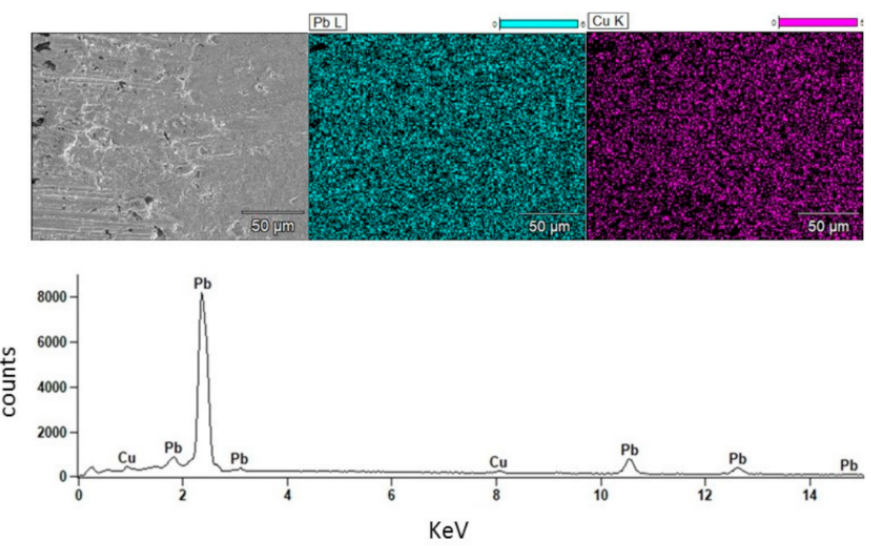
Figure 7. SEM-EDS results for the metallic phase obtained for 40 wt.% Na 2 CO 3 and 0.4 g of SiC to 1000 ◦